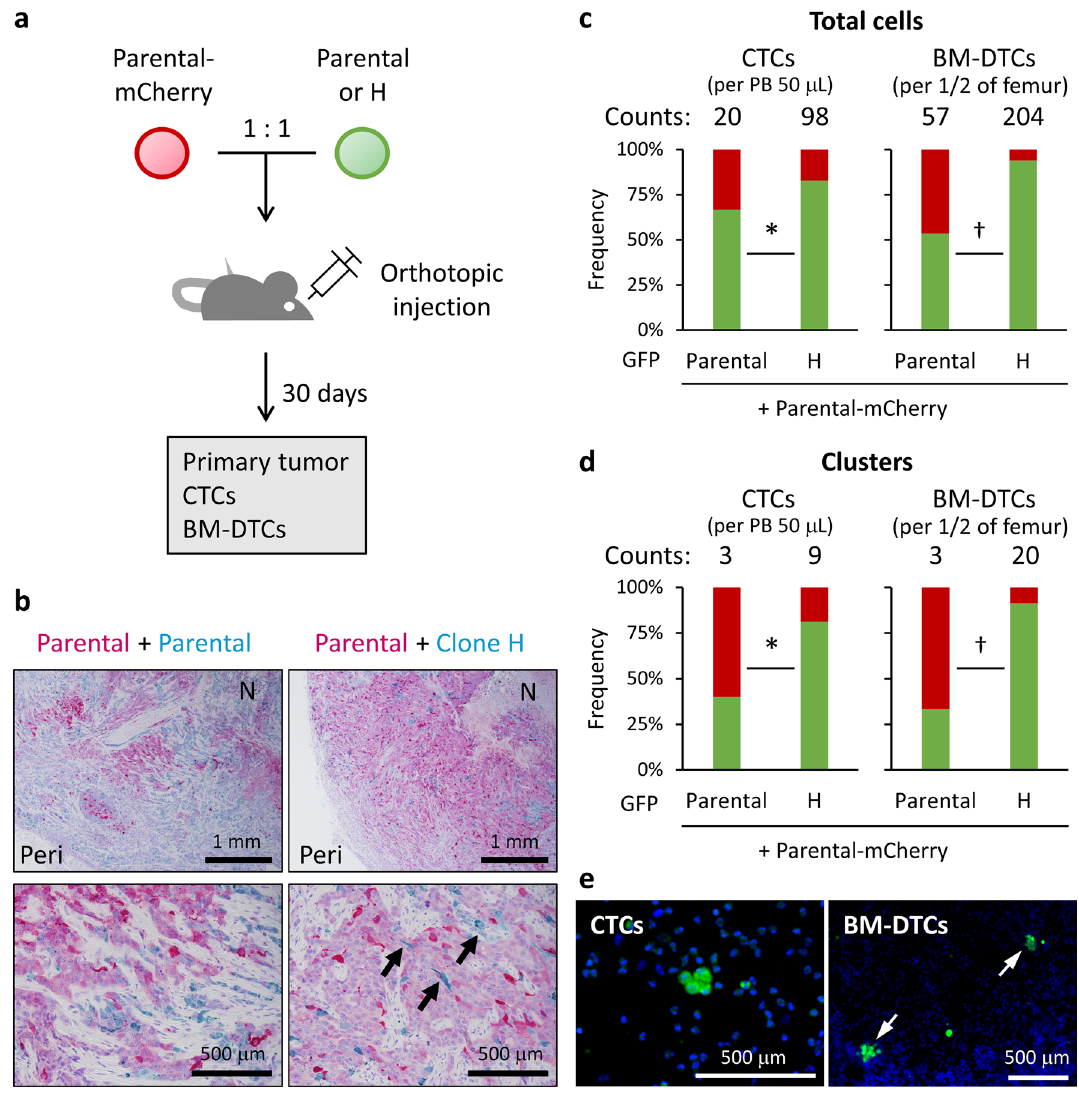
Figure 6. Dominant distant colonization by homotypic CTC clusters. ( a ) Equal numbers of Parental-mCherry and GFP-expressing parental cells (Parental) or clone H were mixed and orthotopically injected into mice. After 30 days, numbers of GFP-positive or mCherry-positive cells or clusters in PB (CTCs) and BM-DTCs were counted. ( b ) Representative images of primary tumors from mixtures of parental/parental cells (left panels) and parental/clone H cells (right panels). Arrows indicate cells originating from clone H. Peri: peripheral lesion. N: necrotic lesion. ( c , d ) Proportions of total cells ( c ) and cell clusters ( d ) positive for only GFP (green) or mCherry (red) in CTCs (left panels) and BM-DTCs (right panels) were calculated for each pooled sample. Average numbers per 50 μL of PB (right panels) and BM for half of the femur (left panels) from each mouse are given above each bar. * p < 0.05; † p < 0.0005 (Pearson’s χ 2 test). ( e ) Representative images of clusters in CTCs (left panel) and BM-DCTs (right